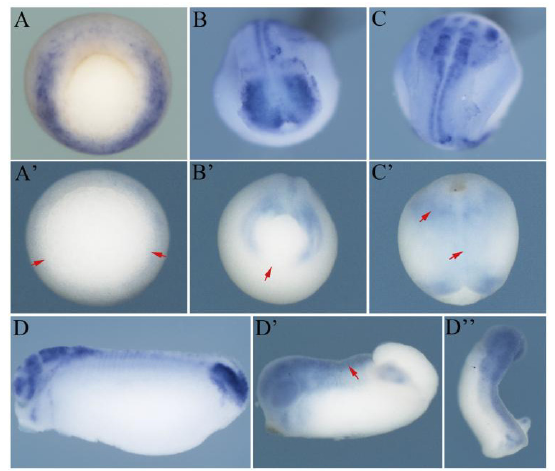
Figure 5. The spatiotemporal expression of Hes5.9 was partially recovered after withdrawing SU5402. The mRNA expression pattern of Hes5.9 was detected by WISH during the middle gastrula in mock embryos ( A ), and the embryos treated with SU5402 ( A’ ), blastopore view with dorsal up; the late neurula mock embryos ( B ) and the embryos with withdrawn SU5402 ( B’ ), posterior view with dorsal up; the late neurula mock embryos ( C ) and the embryos with withdrawn SU5402 ( C’ ), dorsal view with head up; the tailbud stage, mock embryos ( D ) and embryos with withdrawn SU5402, lateral view ( D’ ); and the embryos with withdrawn SU5402 with dorsal view ( D’’ ). The red arrows indicate abnormal expression patterns of Hes5.9 .